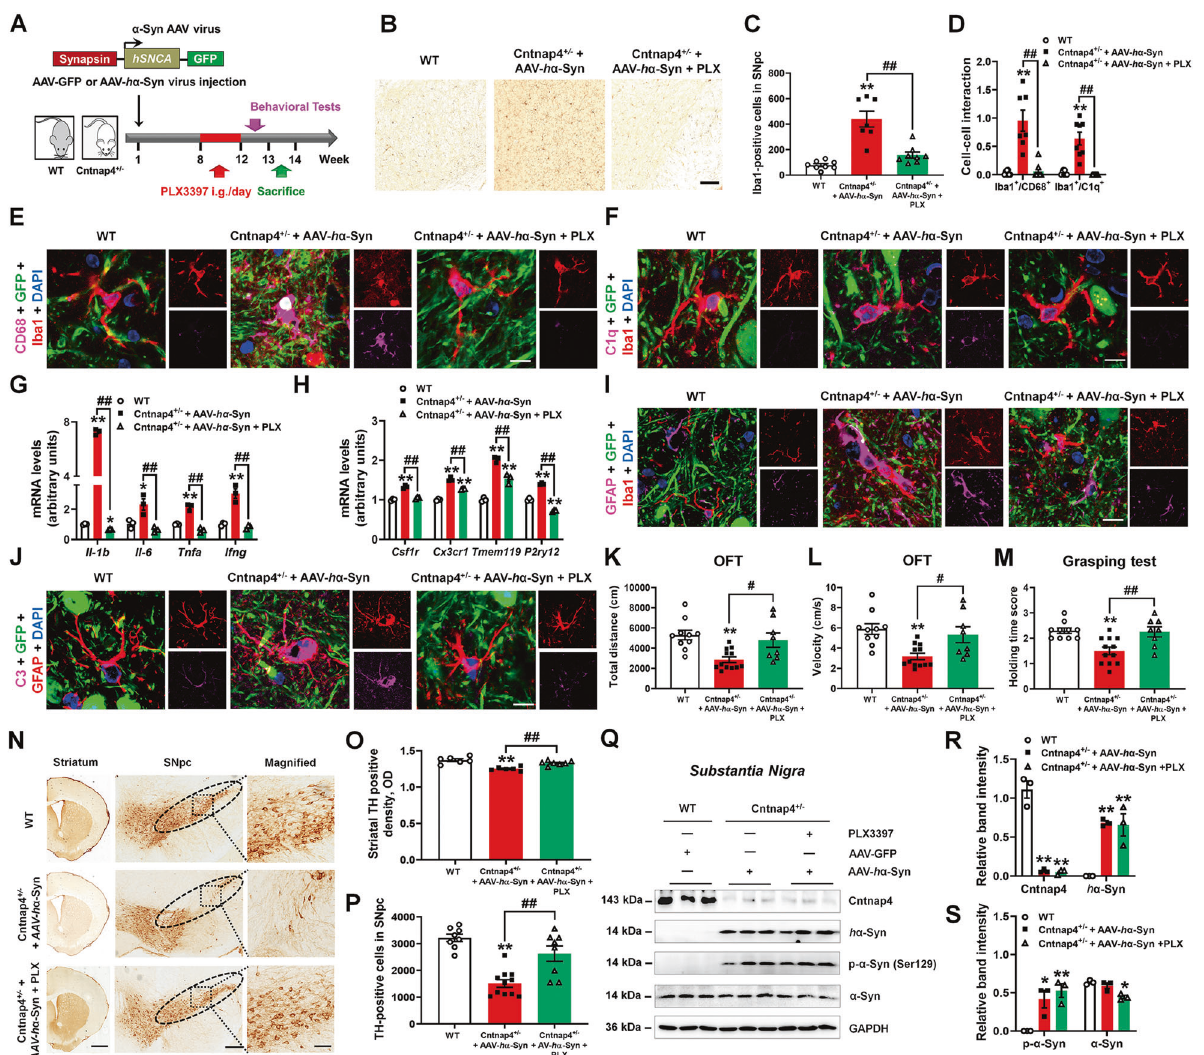
Fig. 5 Eliminating microglia ameliorates AAV- h α -Syn-induced parkinsonian lesions in the Cntnap4 partial de fi cient mice. A Schematic model of the study design. B , C Immunohistochemical staining and quanti fi cation of Iba1-positive cells in the SNpc of WT, Cntnap4 + / − + AAV- h α - Syn, and Cntnap4 + / − + AAV- h α -Syn + PLX3397 groups. Scale bars: 50 μ m. D – F Co-staining and quanti fi cation of Iba1 with CD68 ( E ), and Iba1 with C1q ( F ) in the SNpc of WT, Cntnap4 + / − + AAV- h α -Syn, and Cntnap4 + / − + AAV- h α -Syn + PLX3397 groups. Scale bars: 40 μ m. Magni fi ed images are shown in the right column of panel. Scale bars: 8 μ m; n = 7 – 9. G , H The mRNA expression levels of Il-1b , Il-6 , Tnfa , Ifng , Csf1r , Cx3cr1 , Tmem119 , and P2ry12 were determined by qRT-PCR; n = 3 per group. I , J Co-staining of GFAP with Iba1 ( I ), and GFAP with C3 ( J ) in the SNpc of WT, Cntnap4 + / − + AAV- h α -Syn, and Cntnap4 + / − + AAV- h α -Syn + PLX3397 groups. Scale bars: 8 μ m. K , L Total distance traveled and movement speed in WT, Cntnap4 + / − + AAV- h α -Syn, and Cntnap4 + / − + AAV- h α -Syn + PLX3397 groups. M The grasping test was used to examine the grip strength of mice; n = 10, 12, and 8 in the WT, Cntnap4 + / − + AAV- h α -Syn, and Cntnap4 + / − + AAV- h α -Syn + PLX3397 groups, respectively. N – P Immunohistochemical staining and quanti fi cation of TH-positive cells in WT, Cntnap4 + / − + AAV- h α -Syn, and Cntnap4 + / − + AAV- h α -Syn + PLX3397 groups. Scale bars: 1mm for striatum, 100 μ m for SNpc. Magni fi ed images of TH-positive cells in the SNpc are shown in the right column. Scale bars: 50 μ m; n = 6 – 11. Q – S Protein expression levels of Cntnap4, h α -Syn, phosphorylation of α -synuclein at serine 129, and mouse α -synuclein were determined using western blotting; n = 3 per group. Results are expressed as the mean ±SEM. ** p <0.01, * p <0.05 vs . WT; ## p <0.01, # p <0.05 vs. Cntnap4 + / − + AAV- h α - Syn. Statistical signi fi cance was determined using one-way ANOVA + Tukey ’ s multiple comparisons